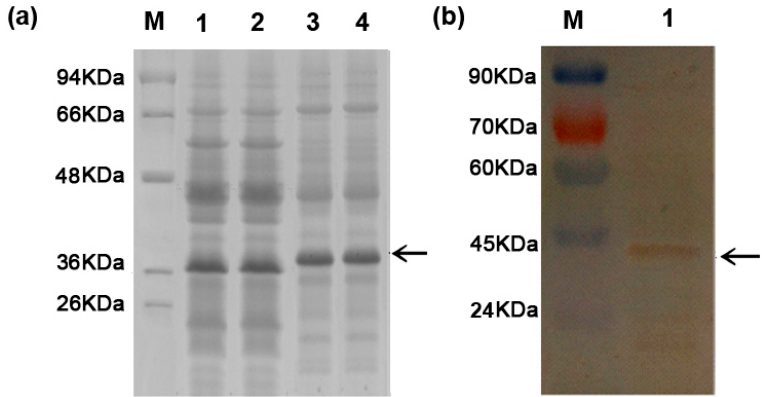
Figure 1. Ecoli expression of the recombinant sugar beet M14 S-adenosylmethionine decarboxylase (BvM14-SAMDC) protein. ( a ) Sodium dodecyl sulfate polyacrylamide gel electrophoresis (SDS-PAGE) analysis of bacterial expression of BvM14-SAMDC. Total soluble protein fractions with the empty vector after 4 h isopropyl β - d -thiogalactoside (IPTG) induction (lanes 1 and 2); and total soluble protein fractions with pET28a- BvM14-SAMDC after 4 h IPTG induction (lanes 3 and 4). ( b ) Immunoblot identification of the purified recombinant BvM14-SAMDC using anti-His antibody. Arrows indicate the BvM14-SAMDC position.